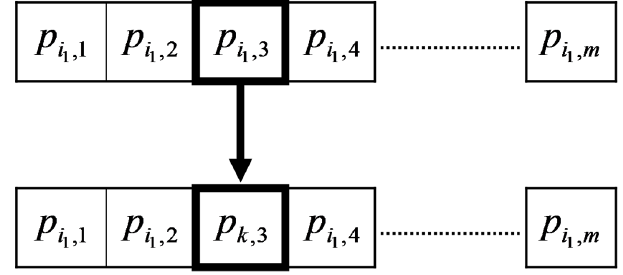
Fig. 2. Scheme of the mutation process. Model parameters for the parent at the top and model parameters for the child at the